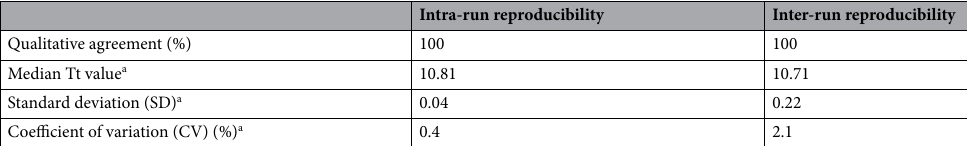
Table 2. Intra- and inter-run reproducibility of the isolation-free SARS-CoV-2 RT-LAMP protocol. To determine the reproducibility a positive pool sample and a negative pool sample was measured in five replicates on three consecutive days. a Median Tt value, standard deviation and the coefficient of variation are calculated based on the results from the positive